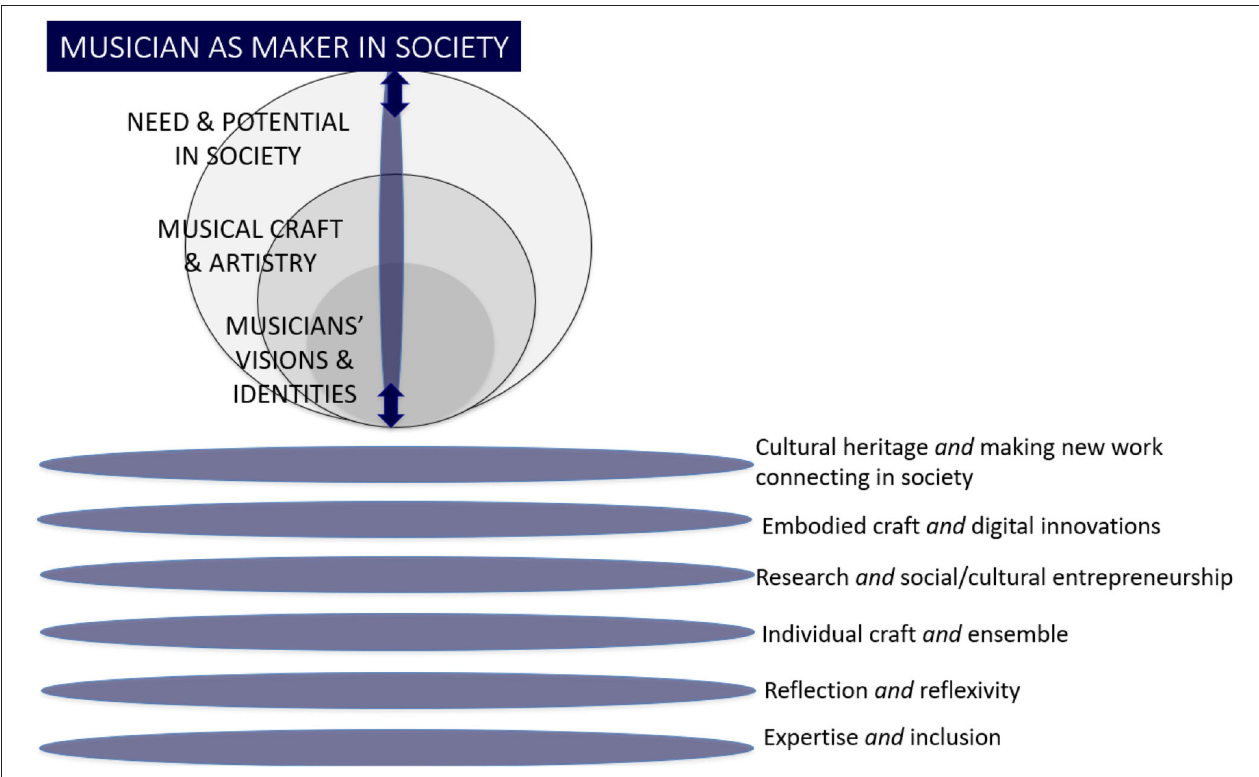
FIGURE 4 | Mobilising lines of development for curriculum paradigm